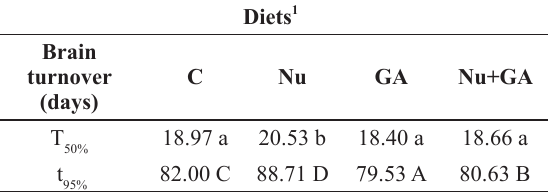
Half-life (T ) and 13 C total substitution (t 50% piglets’ brain according to experimental diets.